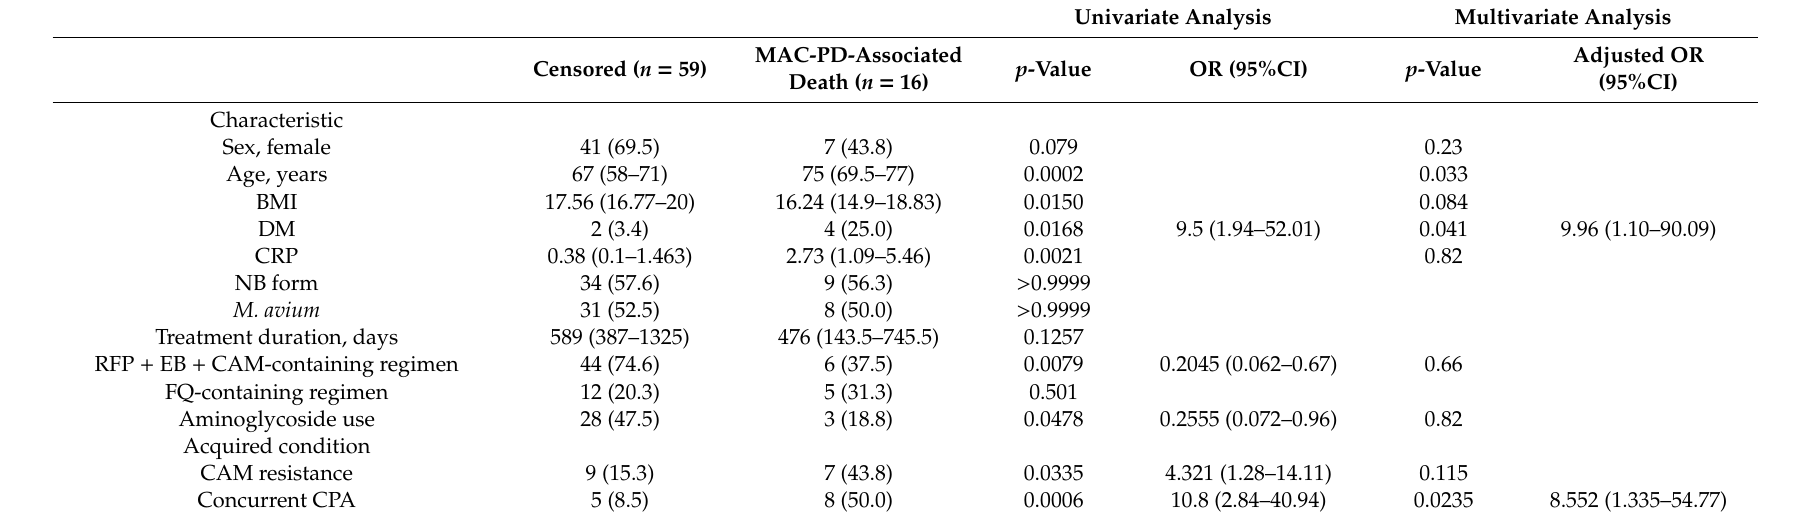
Table 5. Risk factor analysis in patients with cavitary Mycobacterium avium complex pulmonary disease. Univariate Analysis Multivariate